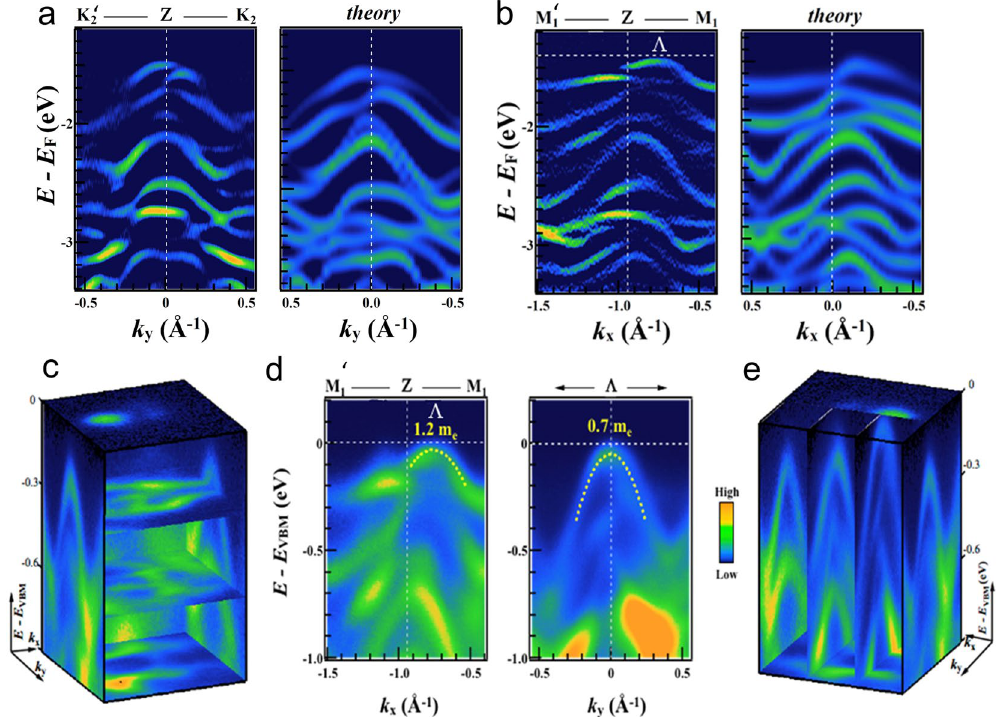
Figure 4. Valence band dispersion. ( a ) Measured and calculated dispersions along the ⁎ b normal to it. In ( a ) and ( b ), the colour scale of the calculated data is arbitrary but in the same sense as the experimental data and indicates the projection of the VB states onto the Re d orbitals. ( c ) and ( e ) panels show the same data of panels ( a ) and ( b ) in 3D plots. ( d ) Dispersion measured by ARPES along the ⁎ b and normal to it (right) passing through the point Λ . Fitted dispersions are shown as dashed lines, giving the effective masses at Λ in these two